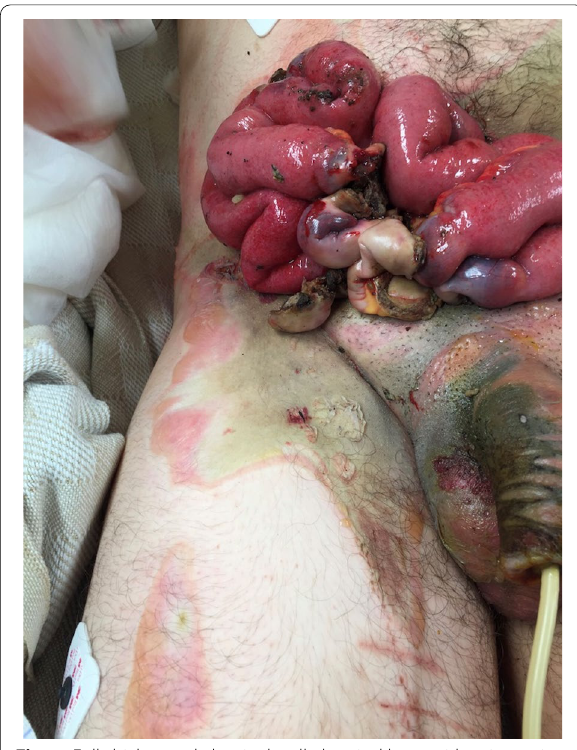
Fig. 3 Right lower extremity full-thickness electrical burn with distal